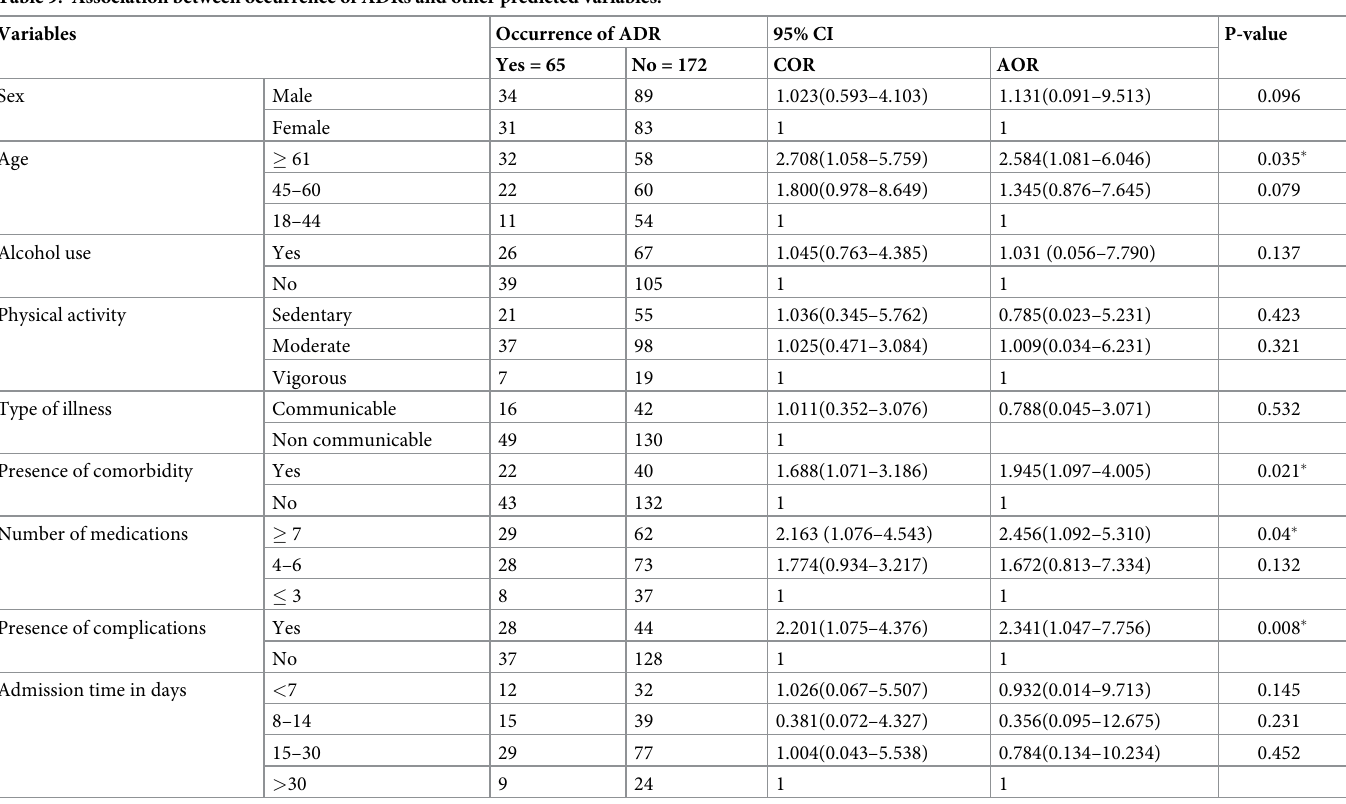
Table 9. Association between occurrence of ADRs and other predicted